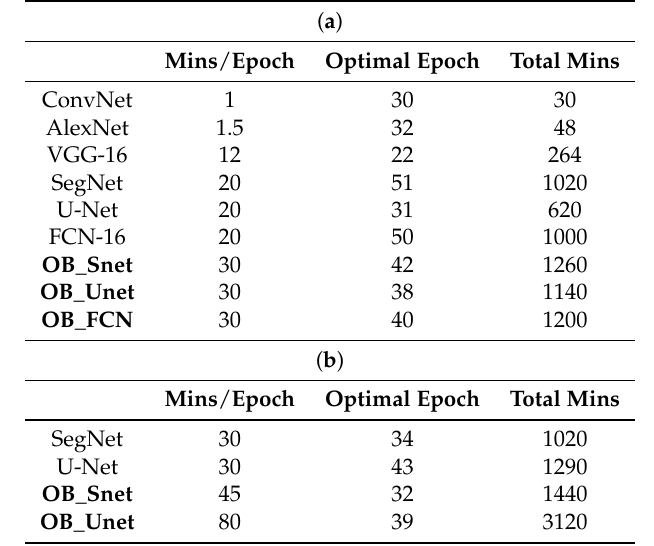
Table 2. The required training time in minutes as well as the optimal epoch that was picked for each architecture are presented for Vaihingen ( a ) and Potsdam ( b ). In bold are the proposed in this paper frameworks, i.e., OB_Snet, OB_Unet and